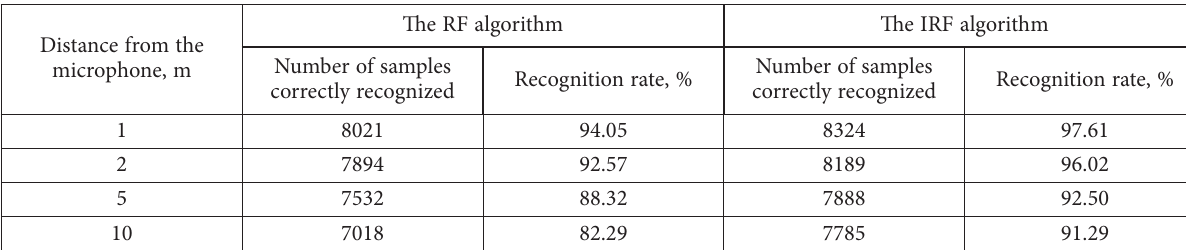
Table 1. Comparison of recognition rates between the two algorithms ( n = 8528) The RF algorithm The IRF algorithm Distance from the Number of samples microphone, m correctly